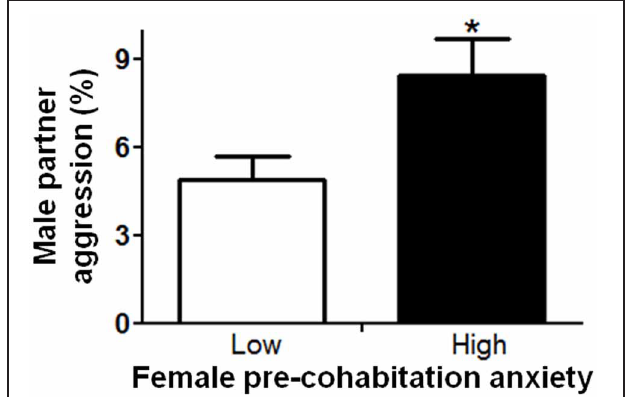
FIGURE 2 | Female anxiety-like behavior, as observed on the elevated plus-maze prior to cohabitation, was associated with increased aggression by the male partner. The mean ± standard error of the mean are presented. ∗ p < 0 . 05.